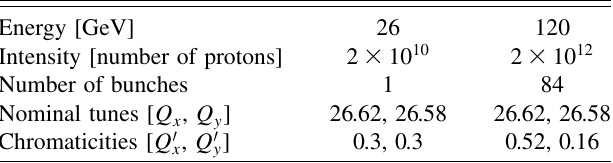
TABLE II. Measured beam conditions for the experiments during 2000.